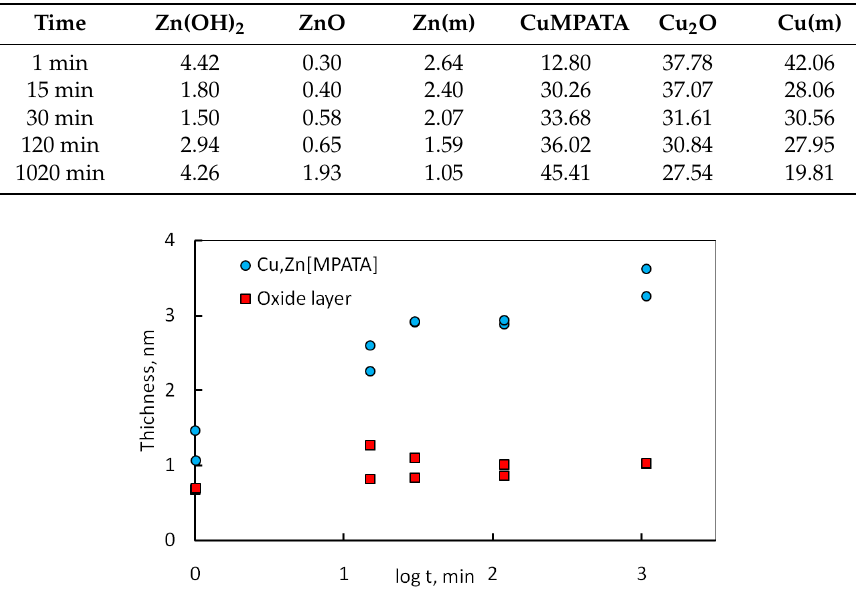
Figure 8. Thickness of the complex and oxide films formed on brass surface depending on exposure time in 0.01 mM MPATA solution.